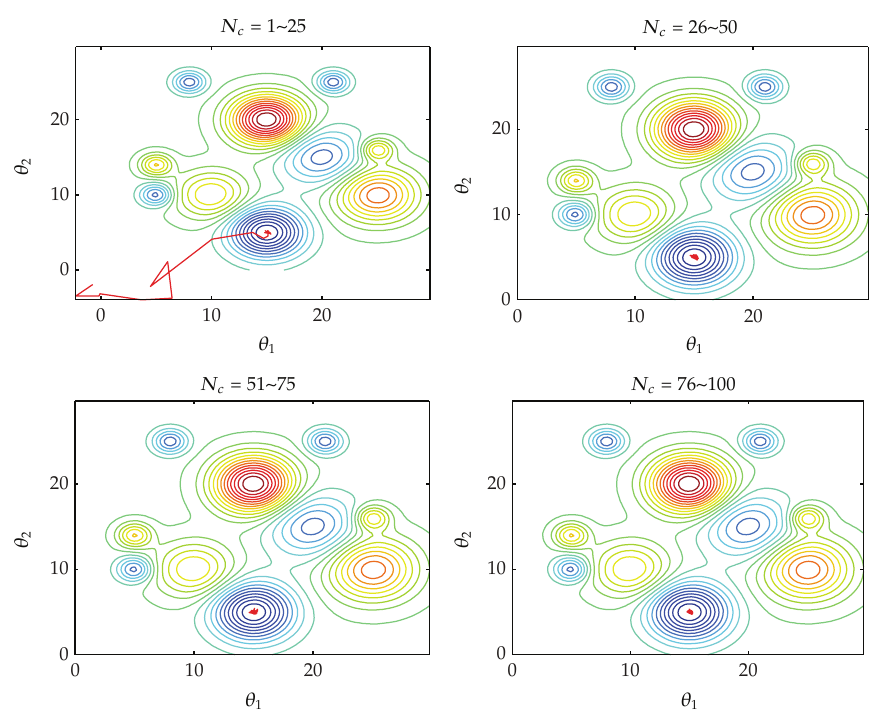
Figure 15: Single bacterium finds the optimum when chemotaxis ranges between 1 ∼ 100.